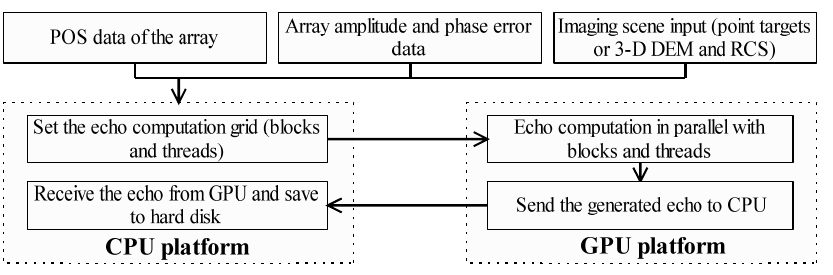
Figure 4. Heterogeneous parallel echo generation simulation with time domain correlation